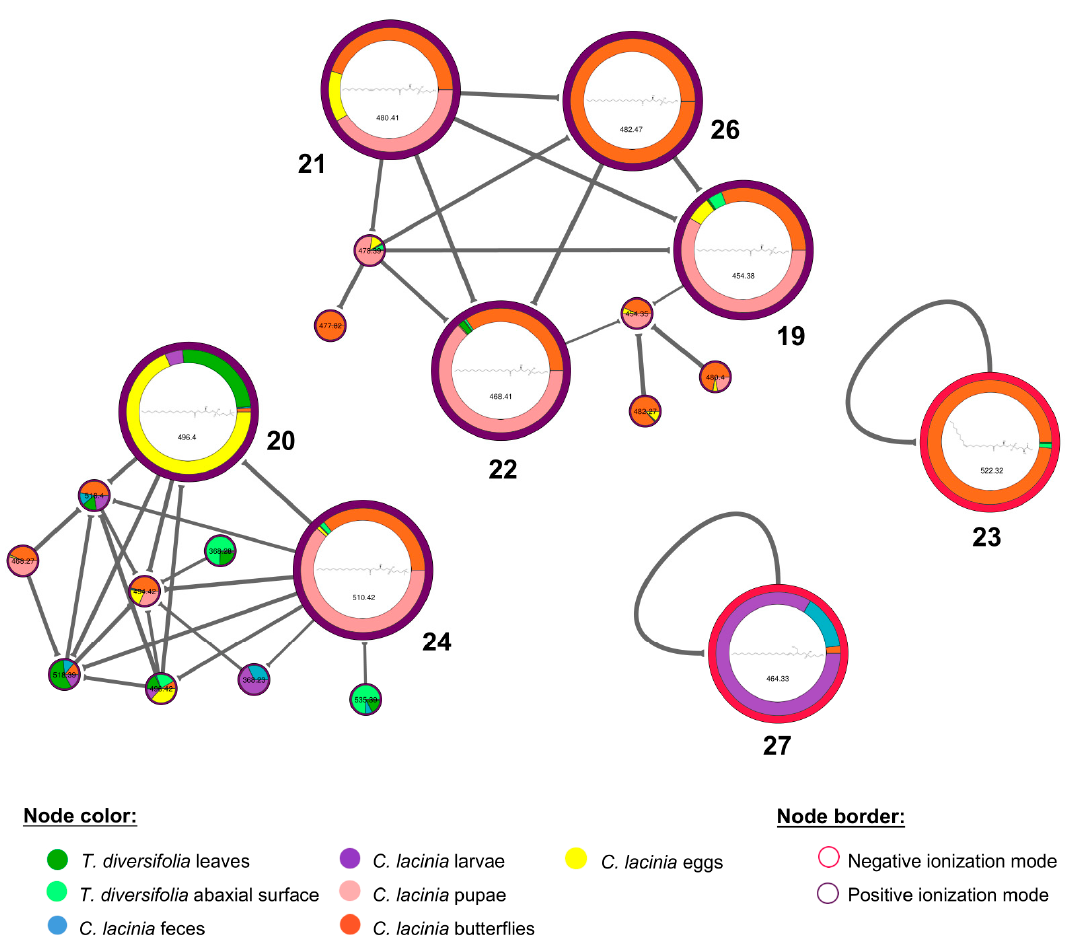
Figure 5. Molecular networking highlighting the clusters of annotated lysophospholipids. Nodes are colored according to the type of sample. Borders of the nodes are colored according to the ionization mode in which the mass feature was obtained.